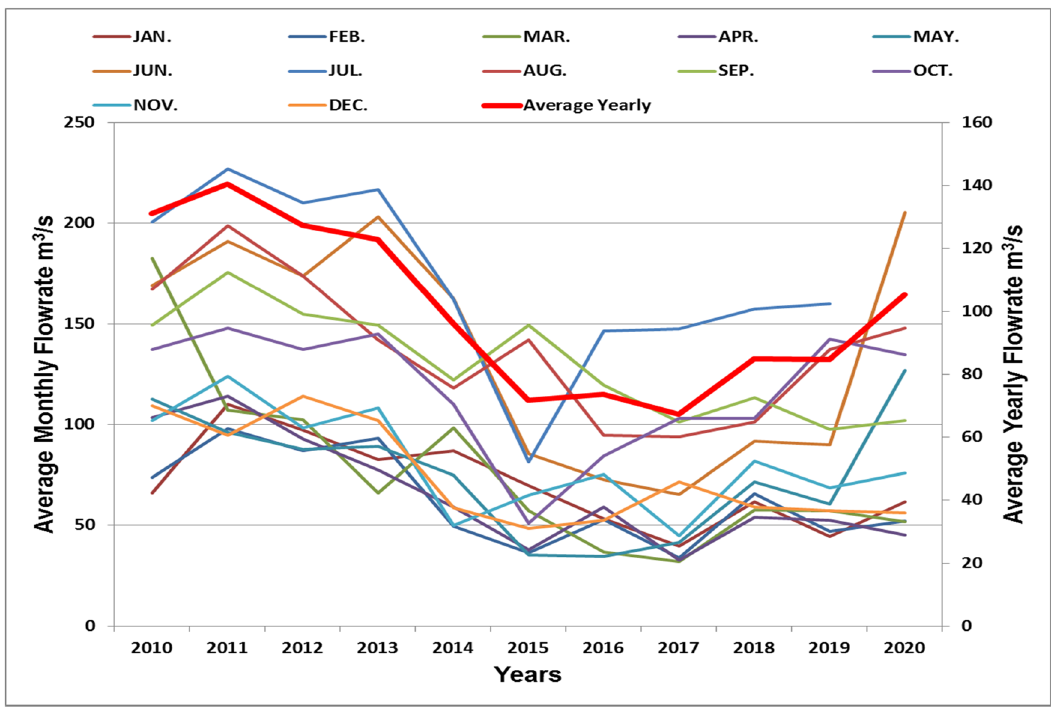
Figure 4: Average fl owrate of the Al - Abbasiya river recorded at 23 stations between 2010 and